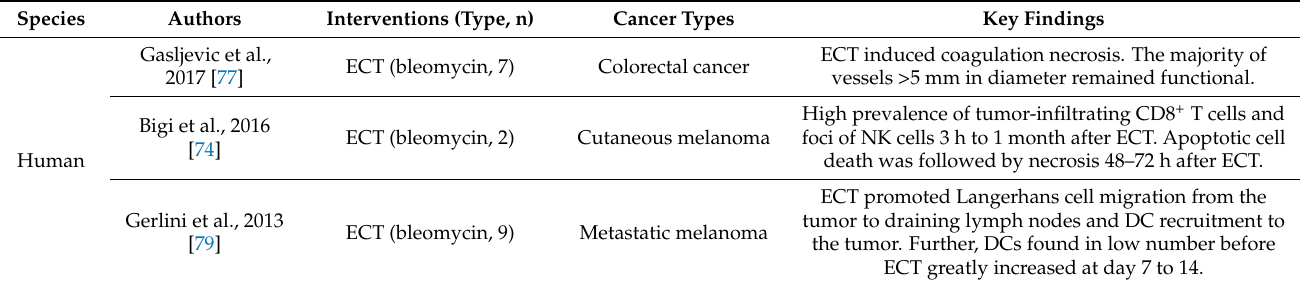
Table 1. Summary of ECT studies investigating the effects on the immune system.